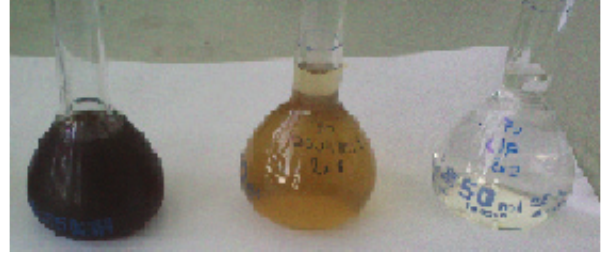
Figure 6: Compost leachate (left), after the treatment with PACl (centre) and after NF